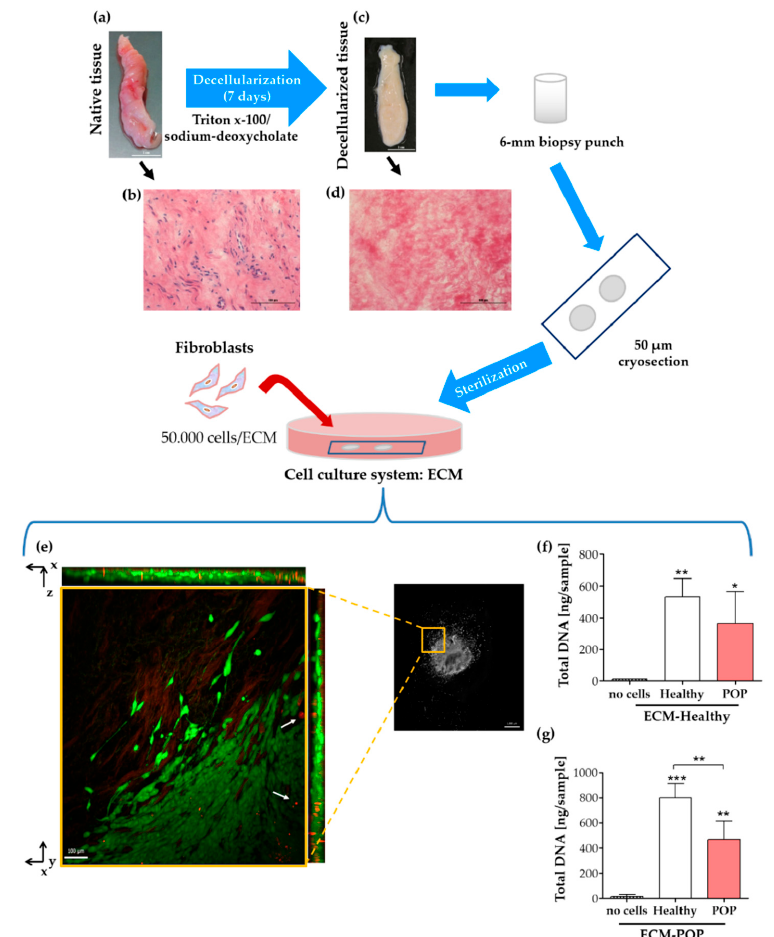
Figure 3. Cell culture system with vaginal extracellular matrix (ECM) and fibroblasts. The top figure shows a graphical representation of a cell culture system that was created using anterior vaginal biopsies ( a,b ). Native tissues were decellularized ( c,d ) and decellularization process was confirmed by haematoxylin-eosin staining of native ( b ) and decellularized tissues ( d ), where matrix is pink and the cell nuclei are blue. The white scale bars are 1 cm ( a,c ) and the black scale bars are 100 µm ( b,d ). Fibroblasts were seeded for 48 h on the ECMs, and viable cells were stained with the LIVE/DEAD ® Viability/Cytotoxicity kit ( e ), following manufacturer’s instructions (molecular probes, Life Technologies). ( e ) A close-up of the living fibroblasts (green) show that they can migrate into the ECMs in the z-plane (as shown in the orthogonal views) and also from the centre to the outside of the matrix. Dead cells (red, white arrows) were mainly found inside and towards the centre of the ECM. Images were acquired with a Zeiss Apotome.2 microscope with an apotome optical sectioner. The left image is an insert of the image on the right and is a maximum intensity projection with the orthogonal sections on the sides. The scale bar of the inserts is 100 µm and of the image on the right is 1 mm. Total DNA of healthy or POP cells seeded on ECM-Healthy ( f ) or ECM-POP ( g ) was measured. Data represents the mean ± SD. Differences between groups were calculated using One-way ANOVA, followed by Tukey’s multiple comparison test. * p < 0.05, ** p < 0.01 and *** p < 0.001 are compared to the first bar (no cells), unless otherwise indicated.